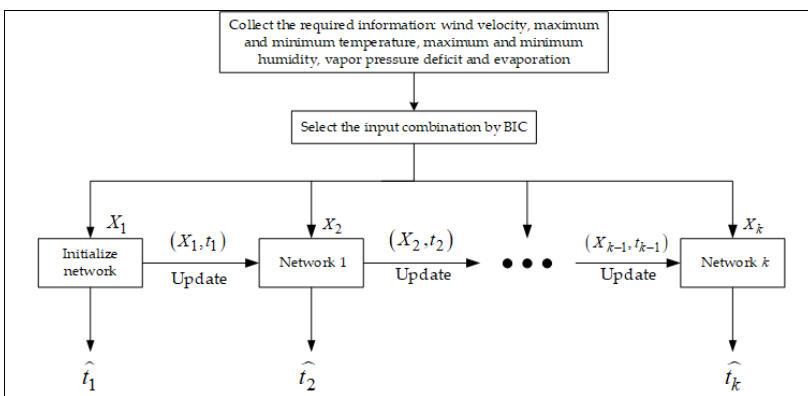
Figure 4. Flowchart of the proposed methodology.